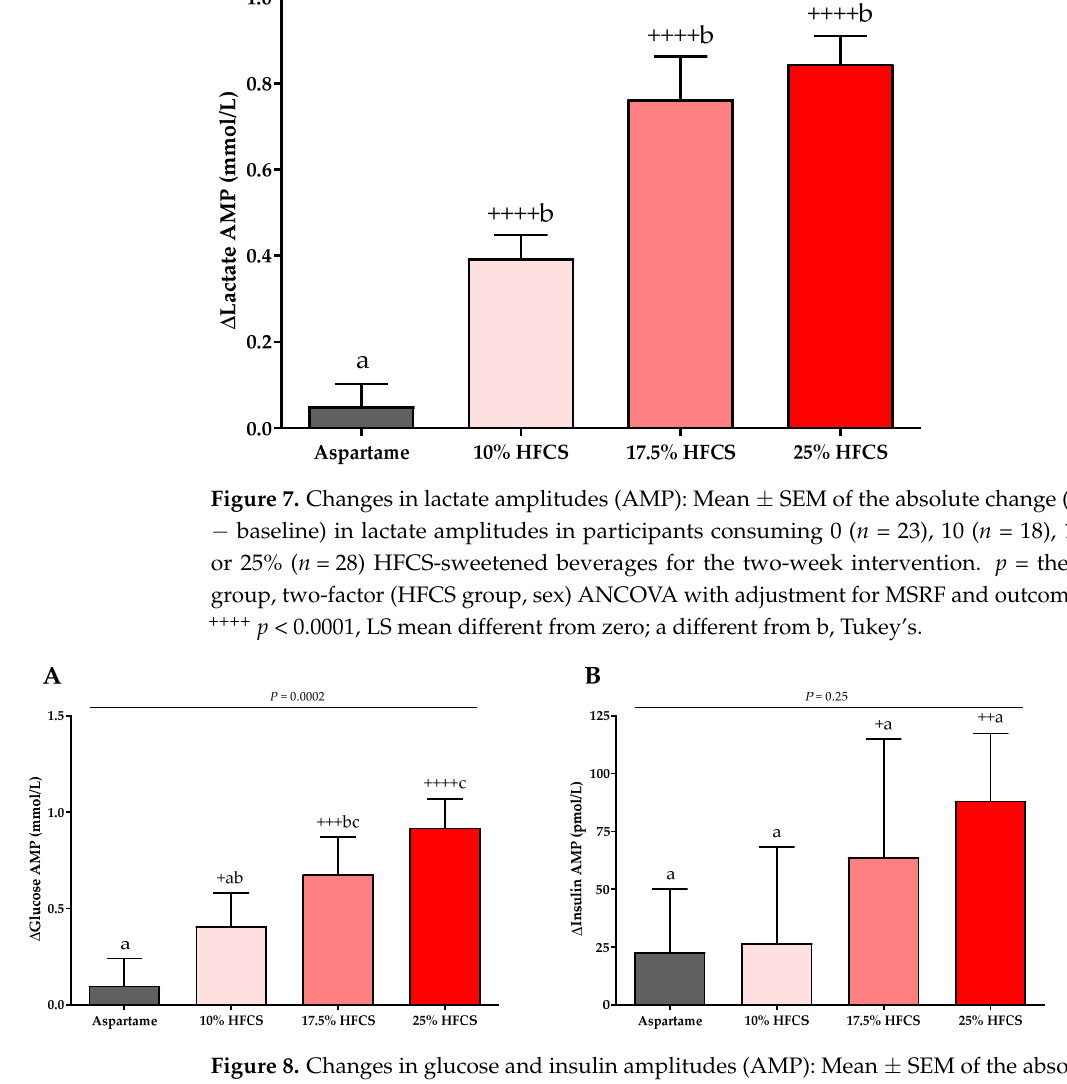
Figure 8. Changes in glucose and insulin amplitudes (AMP): Mean ± SEM of the absolute changes (intervention − baseline) in glucose ( A ) and insulin AMPs ( B ) in participants consuming 0 ( n = 23), 10 ( n = 18), 17.5 ( n = 15), or 25% ( n = 28) HFCS-sweetened beverages for the two-week intervention. p = effect of HFCS group, two-factor (HFCS group, sex) ANCOVA with adjustment for MSRF and outcome at baseline; + p < 0.05, ++ p < 0.01, +++ p < 0.001, ++++ p < 0.0001, LS mean different from zero; a different from b, Tukey’s.